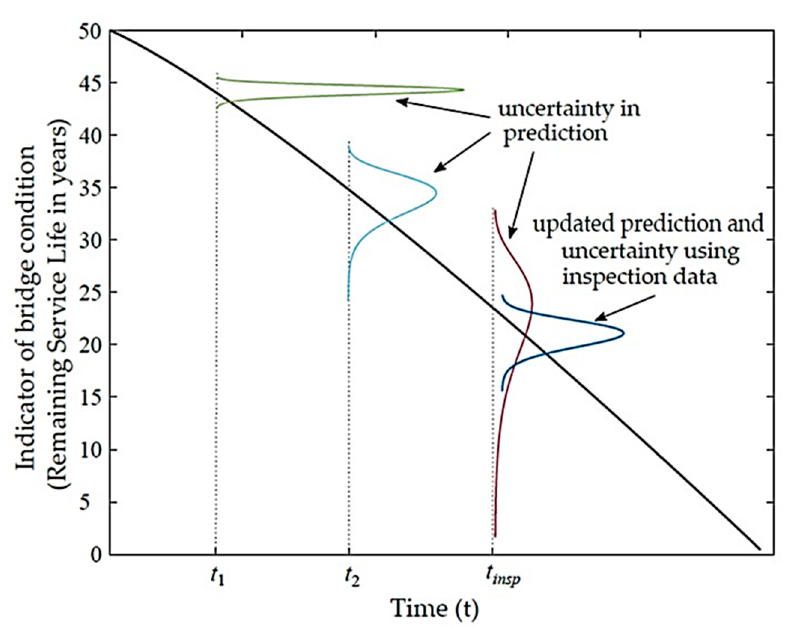
Figure 1. Conceptual representation of increasing uncertainty about bridge condition over time, and the reduction in uncertainty resulting from updated inspection findings.